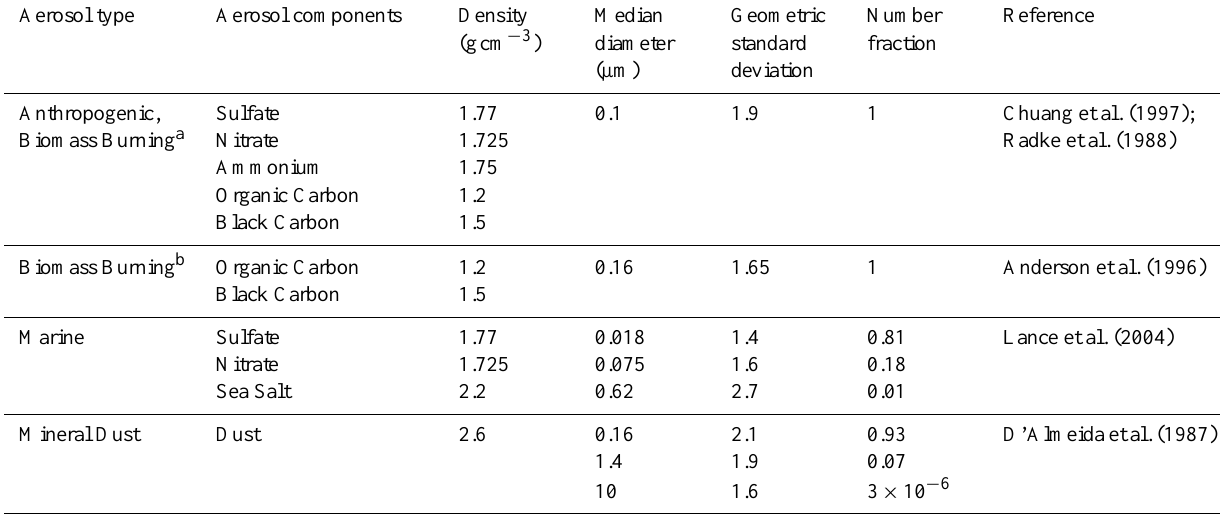
Number Reference Geometric Median fraction standard (gcm − 3 ) diameter deviation (µm)